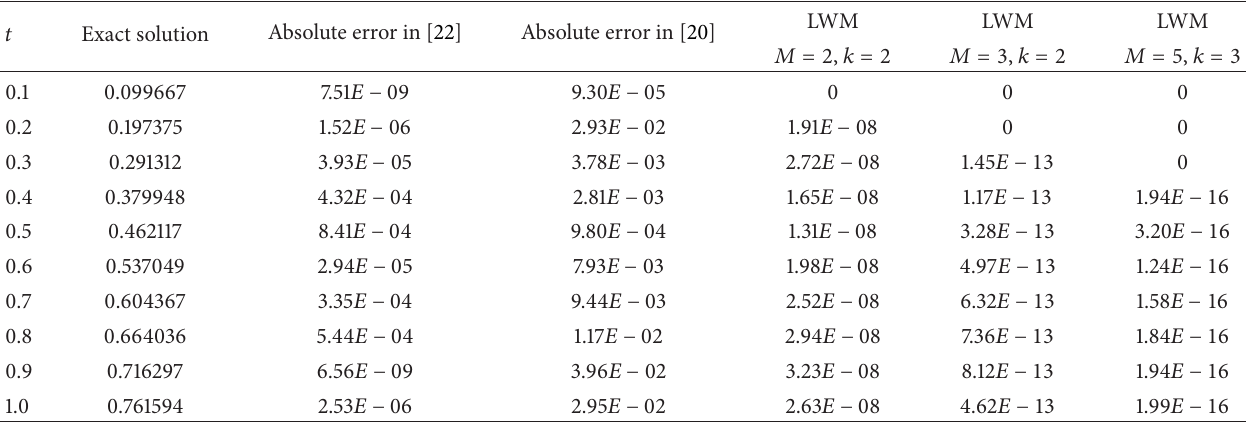
Table 1: Numerical results of Example 1 for 𝛼 = 1 .